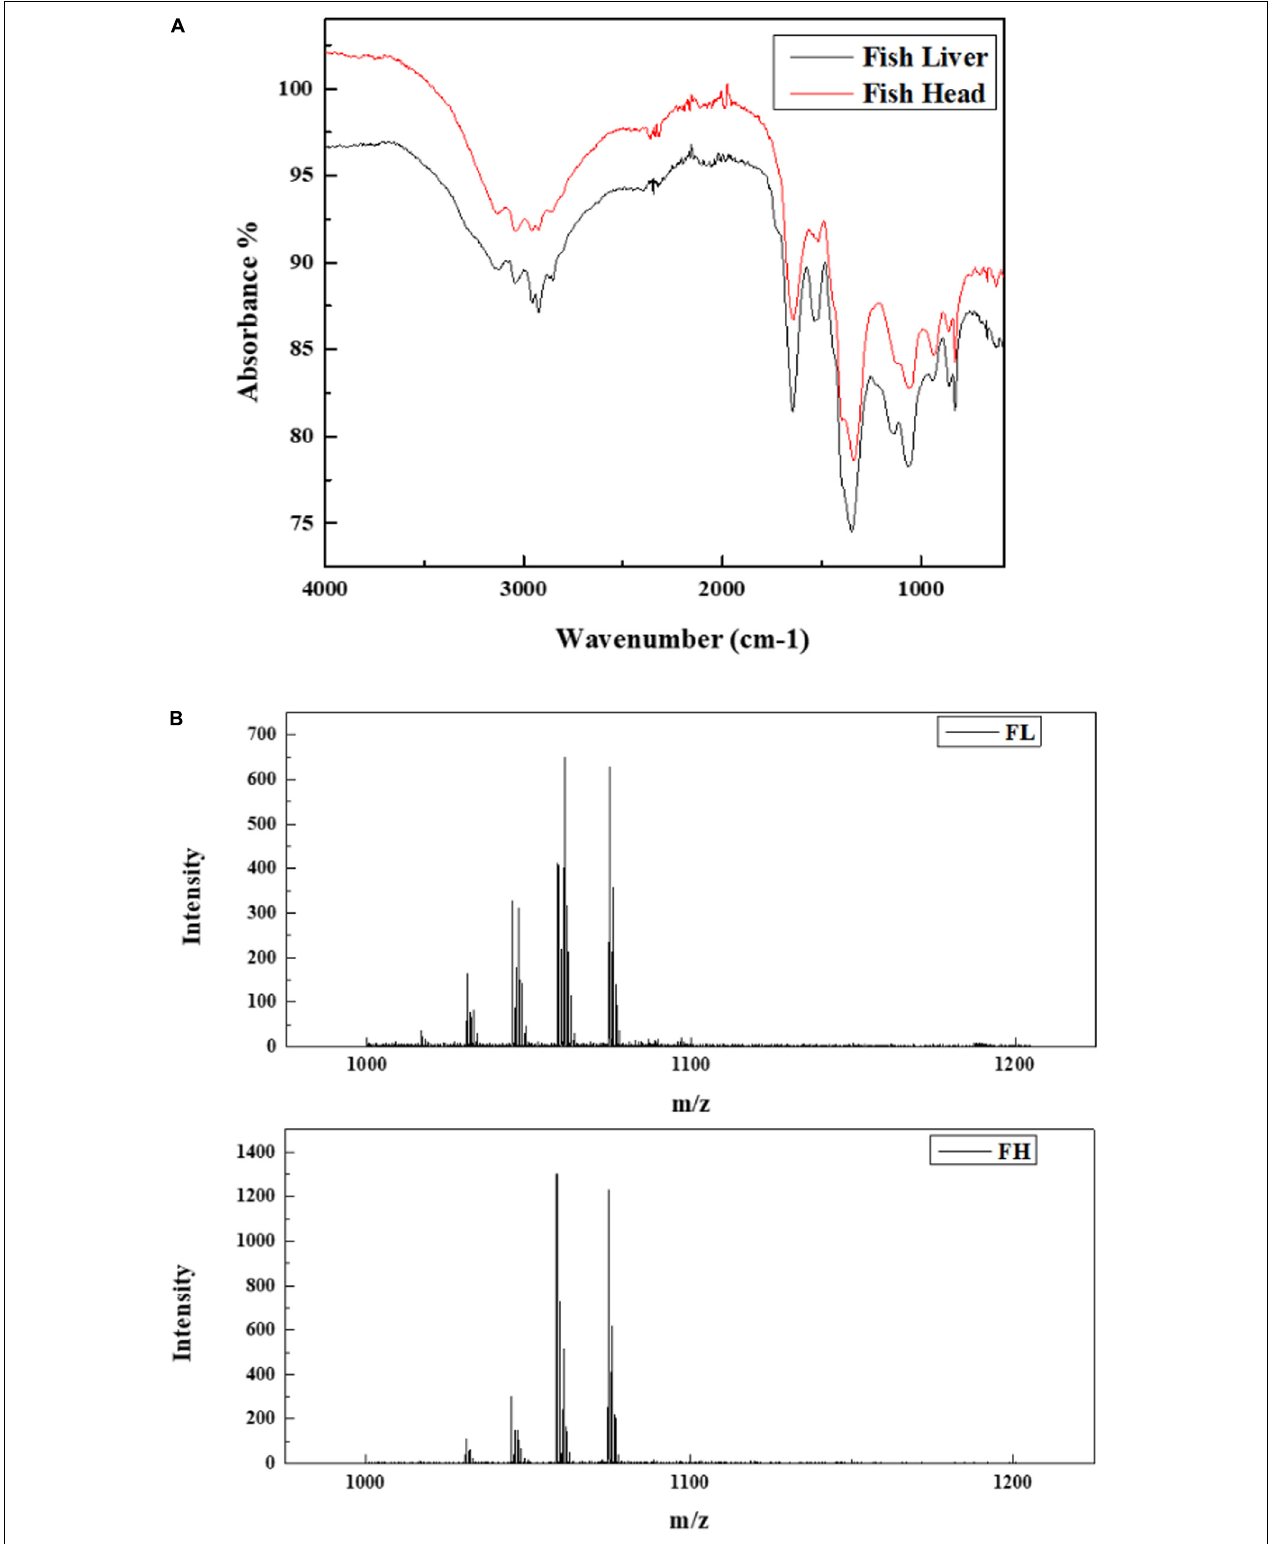
FIGURE 6 | Characterization of biosurfactants generated by Bacillus subtilis N3-1P using fish liver (FL) and fish head (FH) as minimum production medium. (A) FTIR analysis; (B) MALDI-TOF analysis.